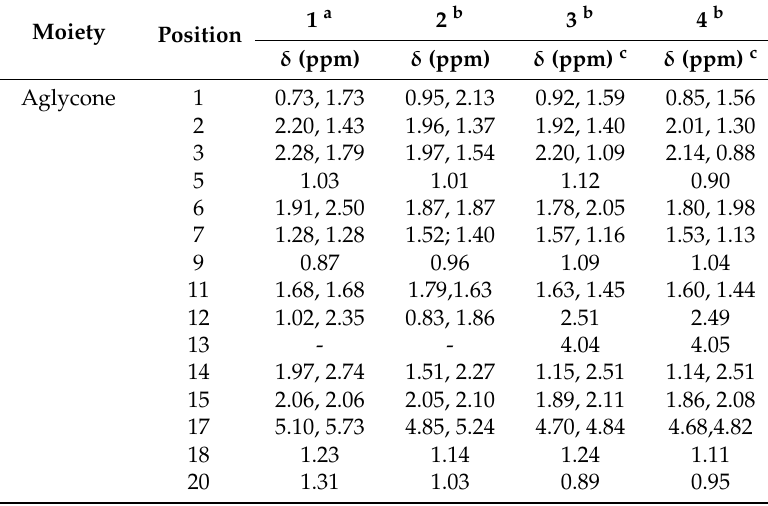
Table 1. 1 H chemical shifts of diterpene glycosides 1 – 4